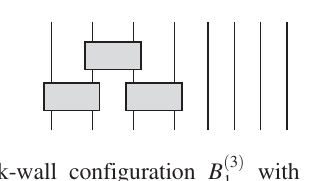
FIG. 5. Brick-wall configuration B ð B ð 2 p − 1 Þ p ¼ 2 . 1 with